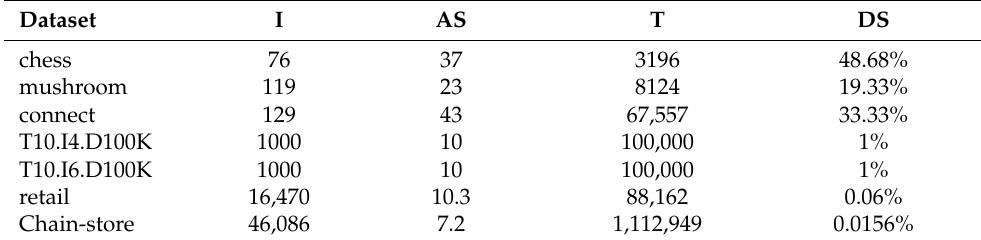
Table 3. Dataset